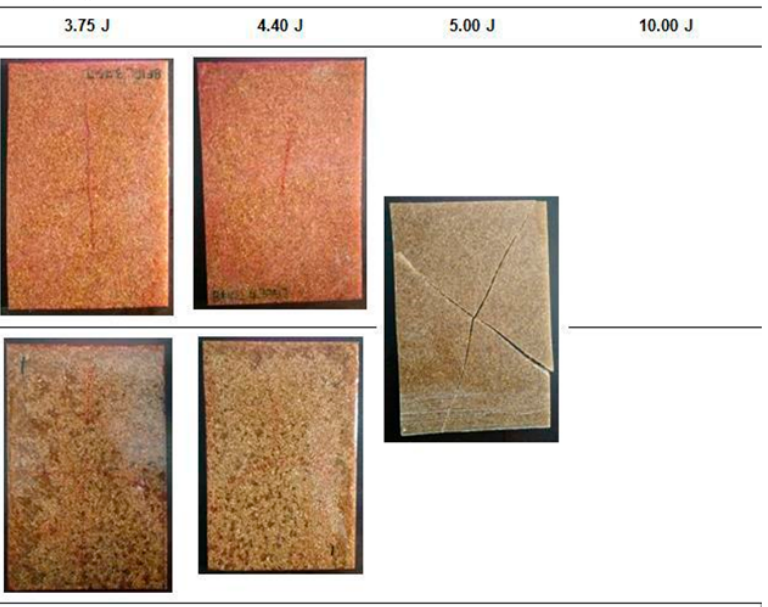
Figure 9. The damage on the impacted samples of EP-BF10 was observed with the help of the dye penetrant.